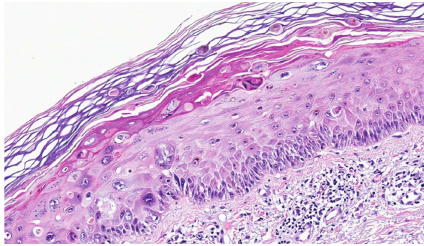
Figure 8: Necrolytic acral erythema: epidermal pallor in the stratum corneum, hyperkeratosis, dyskeratotic keratinocytes, spon- giosis, and a superficial perivascular mixed inflammatory infiltrate in the dermis are seen (hematoxylin-eosin, original magnification × 200) (photo courtesy of Dr. Rajendra